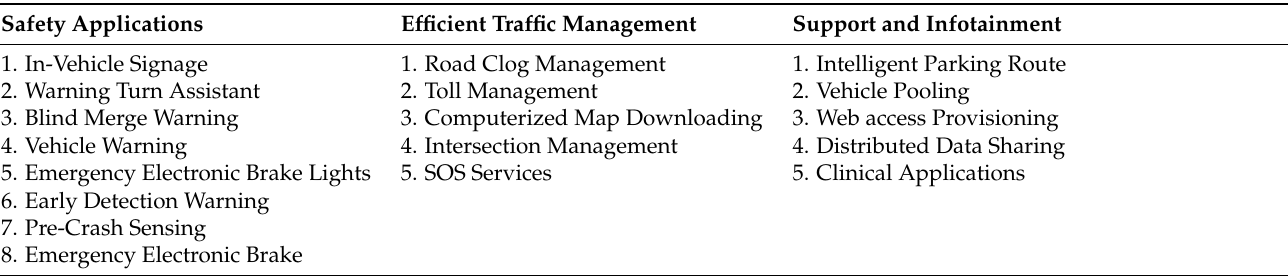
Table 1. Applications of